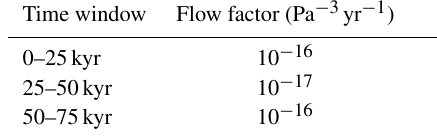
Table 1. The six different EISMINT experiments. Experiment Margin Mass balance moving